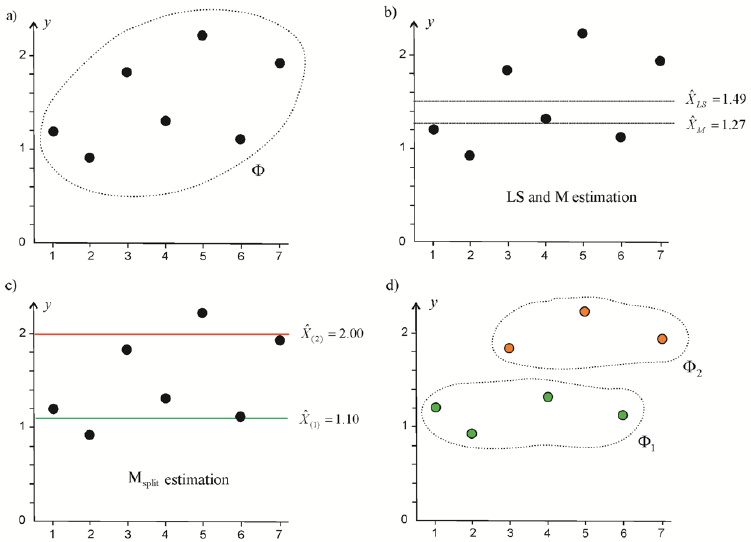
Figure 1. Least squares, robust M-estimate and both M split estimates within a sample observation set ( a ) observation set; ( b ) classical estimates; ( c ) M split estimates; ( d ) observation subsets.